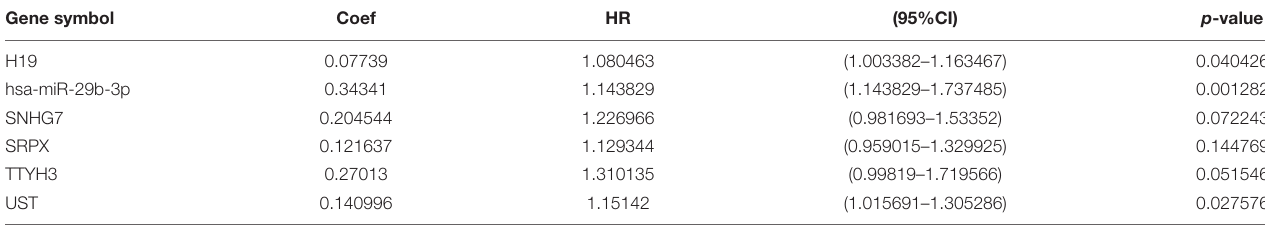
TABLE 2 | Coefficients and multivariable Cox model results for competitive endogenous RNA(ceRNA) regulator network in CRC.